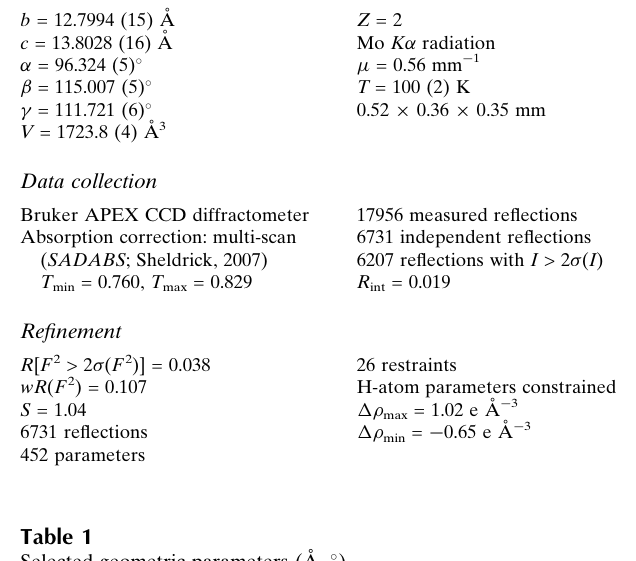
Selected geometric parameters (A˚ , (cid:1)